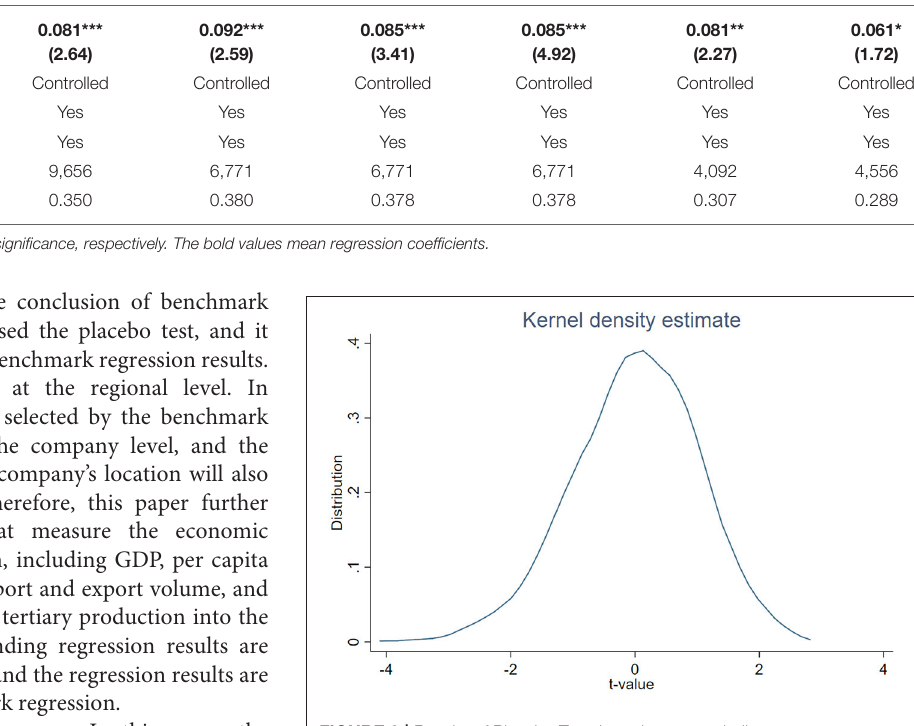
FIGURE 2 | Results of Placebo Test. kernal = epanechnikov, bandwidth =